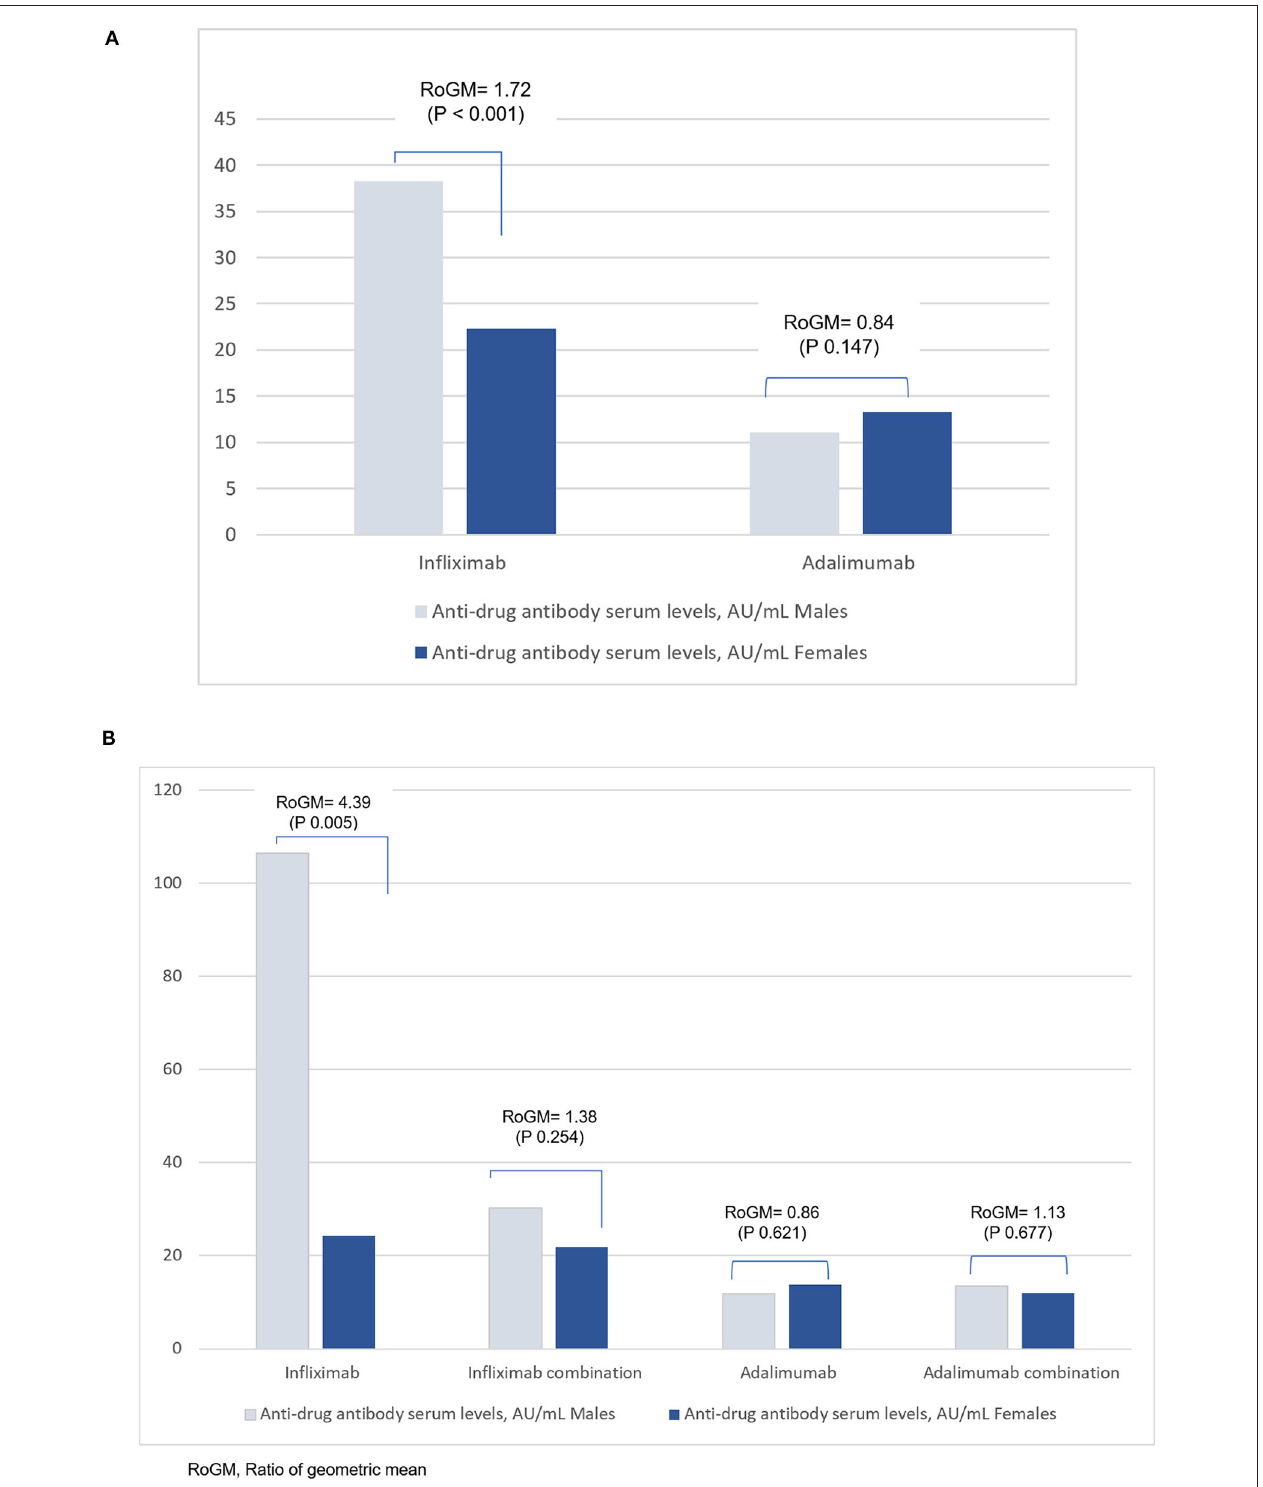
FIGURE 1 | (A) Anti-drug antibody levels in male and female patients with IBD in the total sample analysis for infliximab and adalimumab. The Y-axis corresponds to the geometric mean of the anti-drug antibodies serum levels. (B) Anti-drug antibody serum levels in males and females with IBD in the subgroup analysis for Infliximab and Adalimumab. The Y-axis corresponds to the geometric mean of the anti-drug antibodies serum levels.